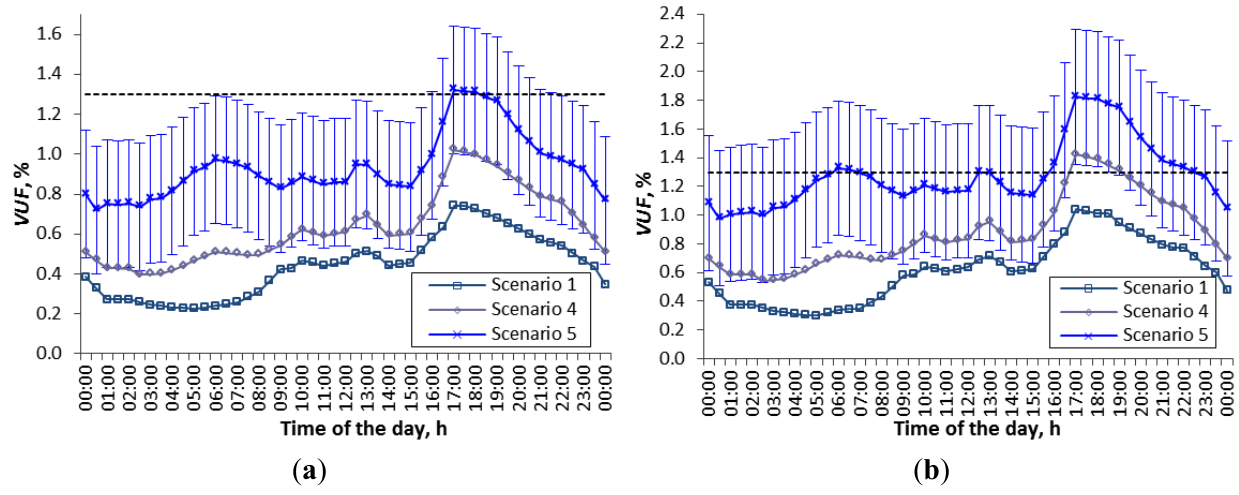
Figure 5. 𝑉𝑈𝐹 s for unbalanced SWT penetration at: ( a ) the LV busbar and ( b ) remote end of the LV cables.